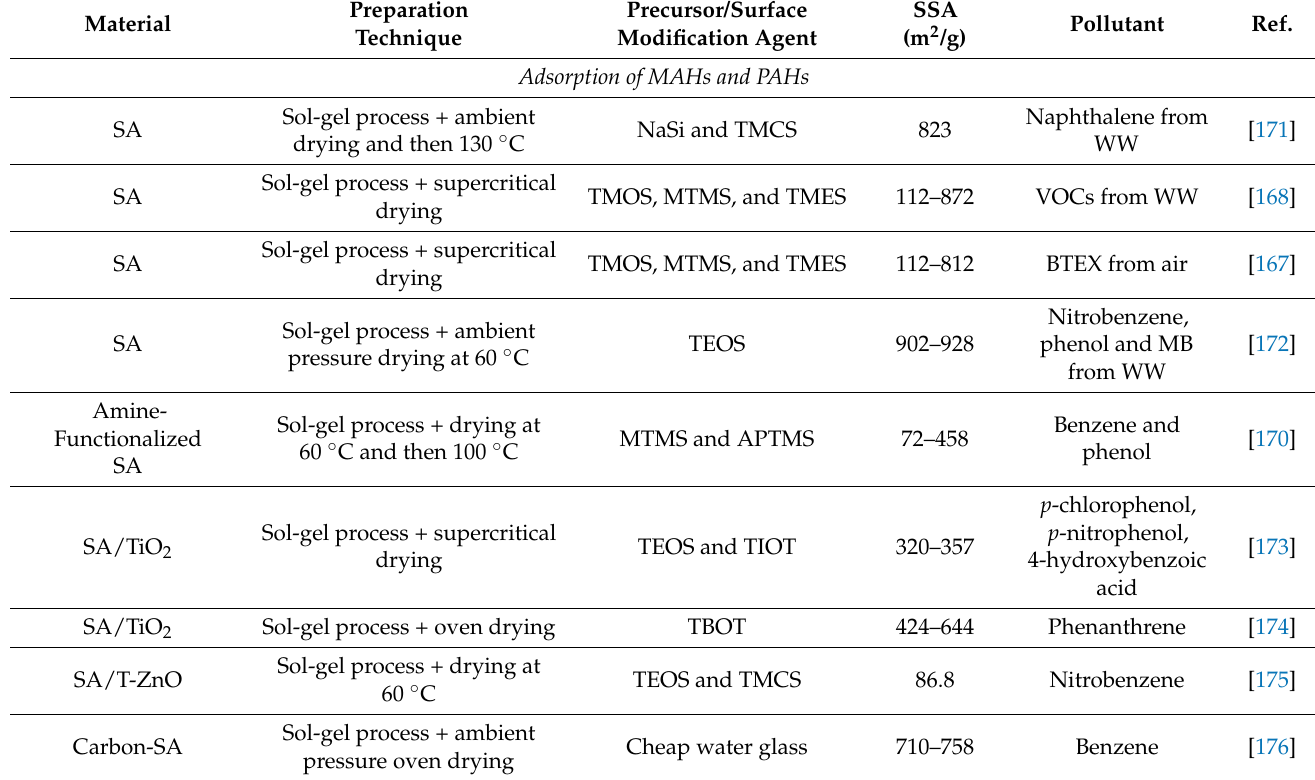
Table 5. AO7: acid orange 7; APTMS: (3-aminopropyl)trimethoxysilane; AAAPTMS: N1-(3-trimethoxysilylpropyl)di- ethylene triamine; BiOX (X = Cl, Br, I): bismuth oxyhalides; BNP: bismuth nitrate pentahydrate; CR: Congo red; CV: crystal violet; MAHs: monoaromatic hydrocarbons; DVTHP: 2,5-divinyltrimethoxysilanethiophene; HMDZ: hexamethyldisilazane; MB: methylene blue; MO: methyl orange; MPTMS: 3-mercaptopropyl)trimethoxysilane; MTES: